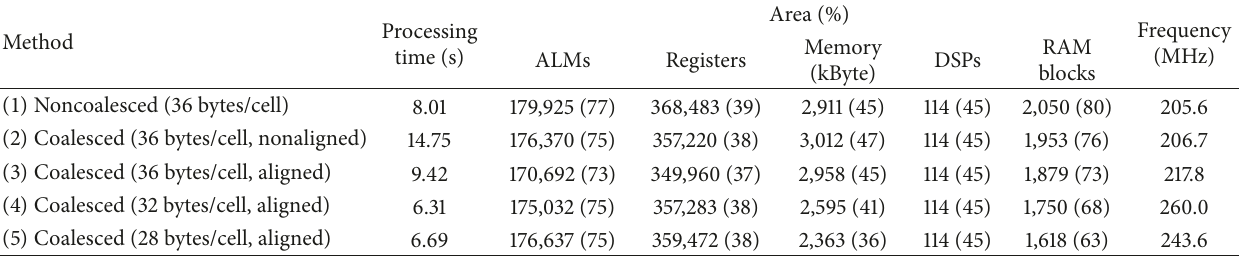
Table 1: Comparison of the FPGA accelerators with different data access methods using DE5 board.